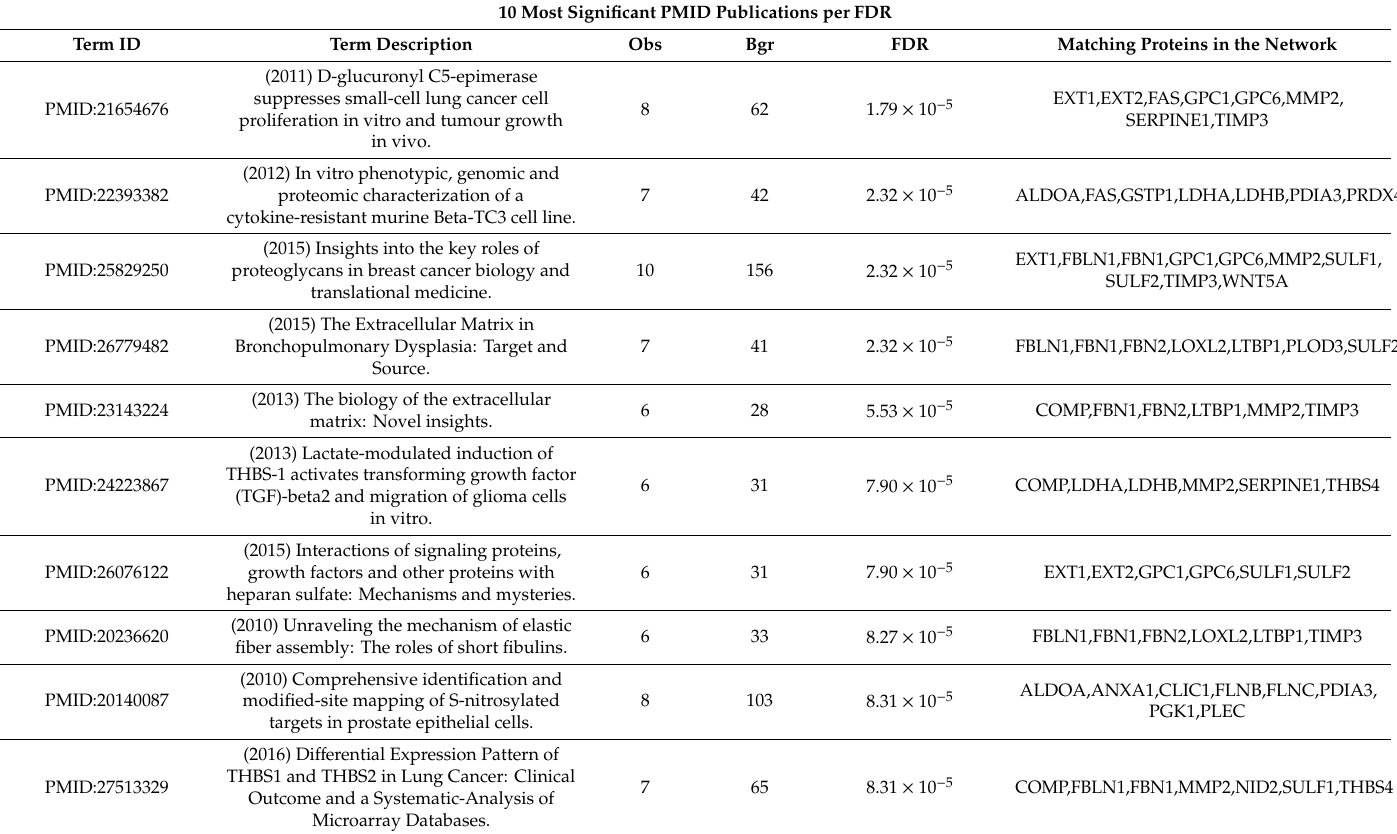
10 Most Significant PMID Publications per